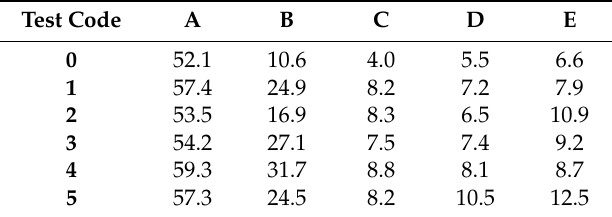
Table 3. Depth reached, in microns, after a single repetition for the different LBM process parameters.